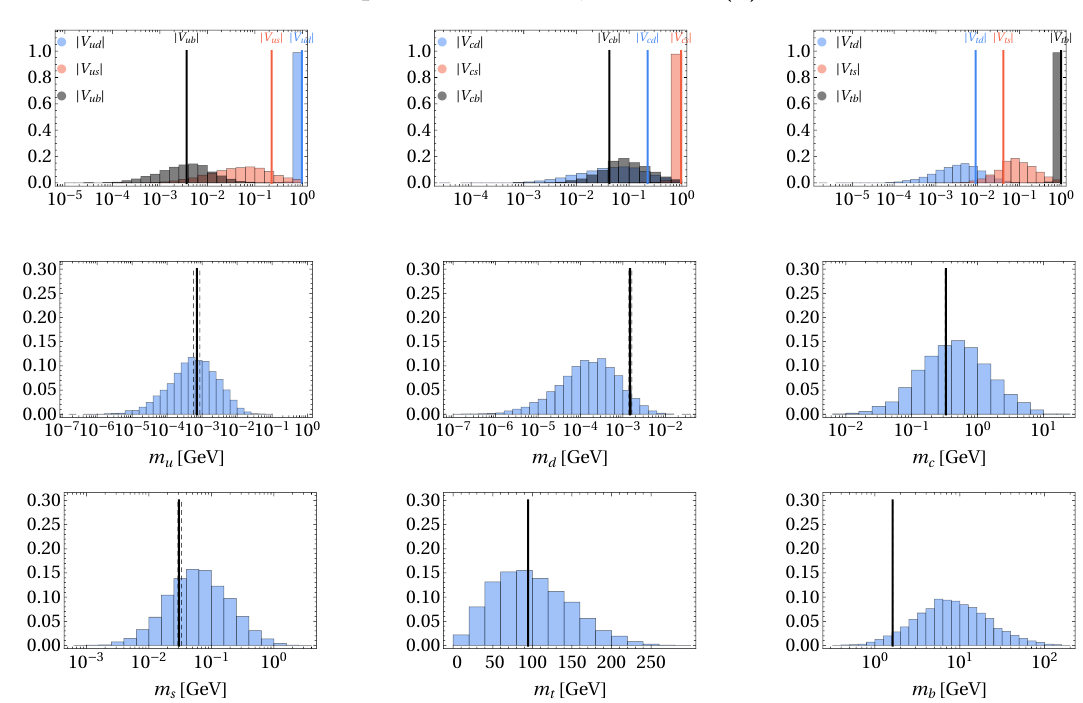
Figure 8 . Distributions of the CKM matrix elements and quark masses generated in the numerical scan with 5000 runs in the case of coupled FN chains, see text for